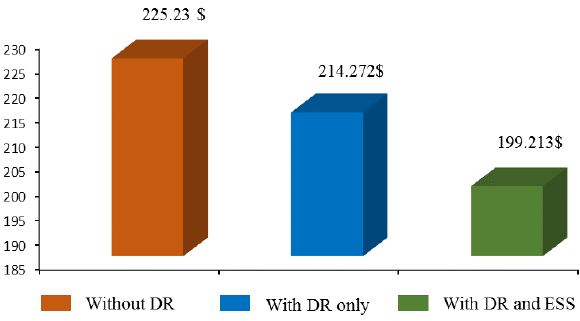
Figure 15. Cost comparison for three test cases.